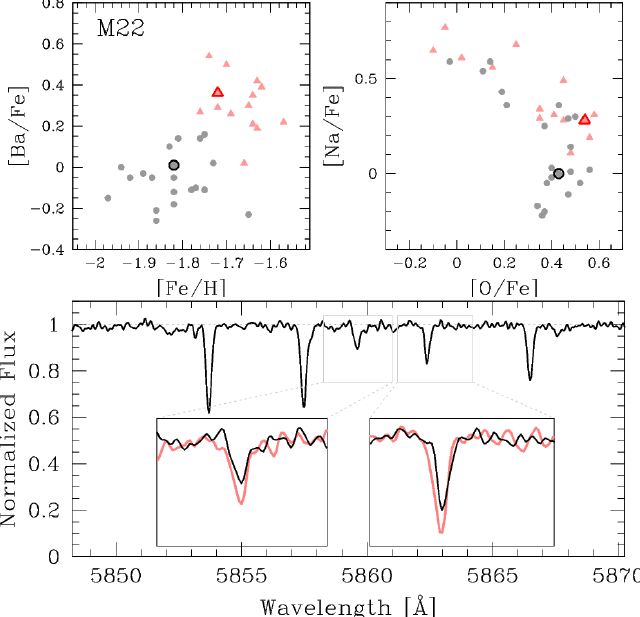
Figure 6. ( Upper panels ) Barium against iron (left) and sodium against oxygen abundance (right) for stars in the Type II GC, M22; s -rich/Fe-rich and s -poor/Fe-poor stars are represented with black and red symbols, respectively. ( Bottom panels ). Normalized spectrum of the star that is marked with large black circles in the upper panels. The black and red lines in the insets compare the spectra of the metal-poor and metal-rich star, respectively, (large symbols in the upper panels) centered around two FeI lines. Since these two stars share very similar stellar parameters, the fact that Fe lines differ significantly is a signature of metallicity difference. The spectra and chemical abundance that we use to draw this Figure are taken from